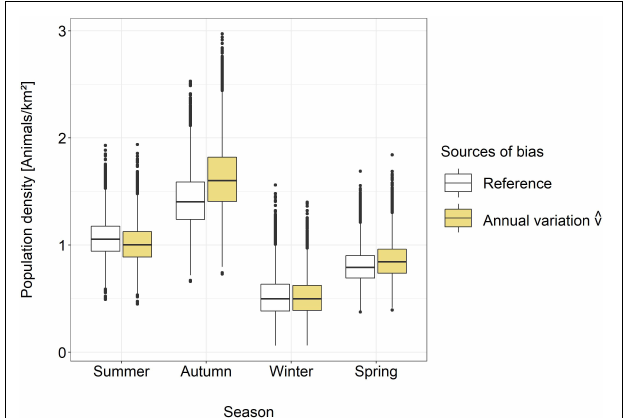
FIGURE 6 | Comparison between the REM estimates of red deer females obtained using speed estimates derived from GPS telemetry data from the study period and from other years. GPS telemetry data from the camera trap study period was available only for red deer females; therefore the analysis was restricted to this subgroup (number of individuals in the study period: 46, total number of collared red deer females: